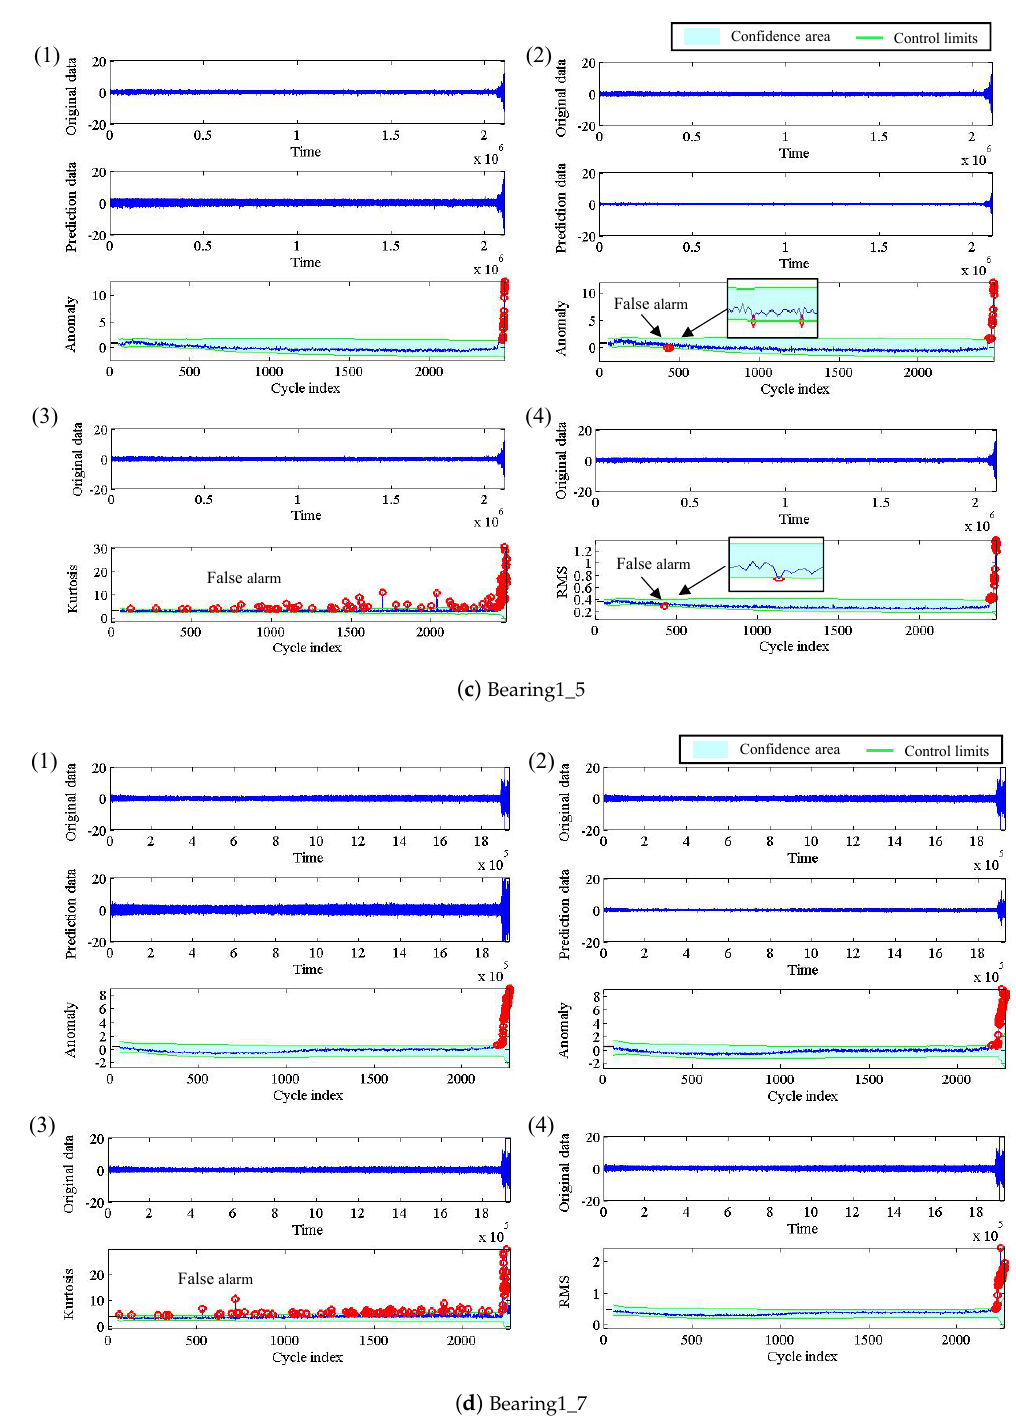
Figure 4. Results of change detection of bearing early failure detection: ( a ) bearing 1; ( b ) bearing 2; ( c ) bearing 3; ( d ) bearing 4. In each piece of testing data: ( 1 ) the result by DE model; ( 2 ) the result by ARIMA model; ( 3 ) the result by Kurtosis, and ( 4 ) the result by